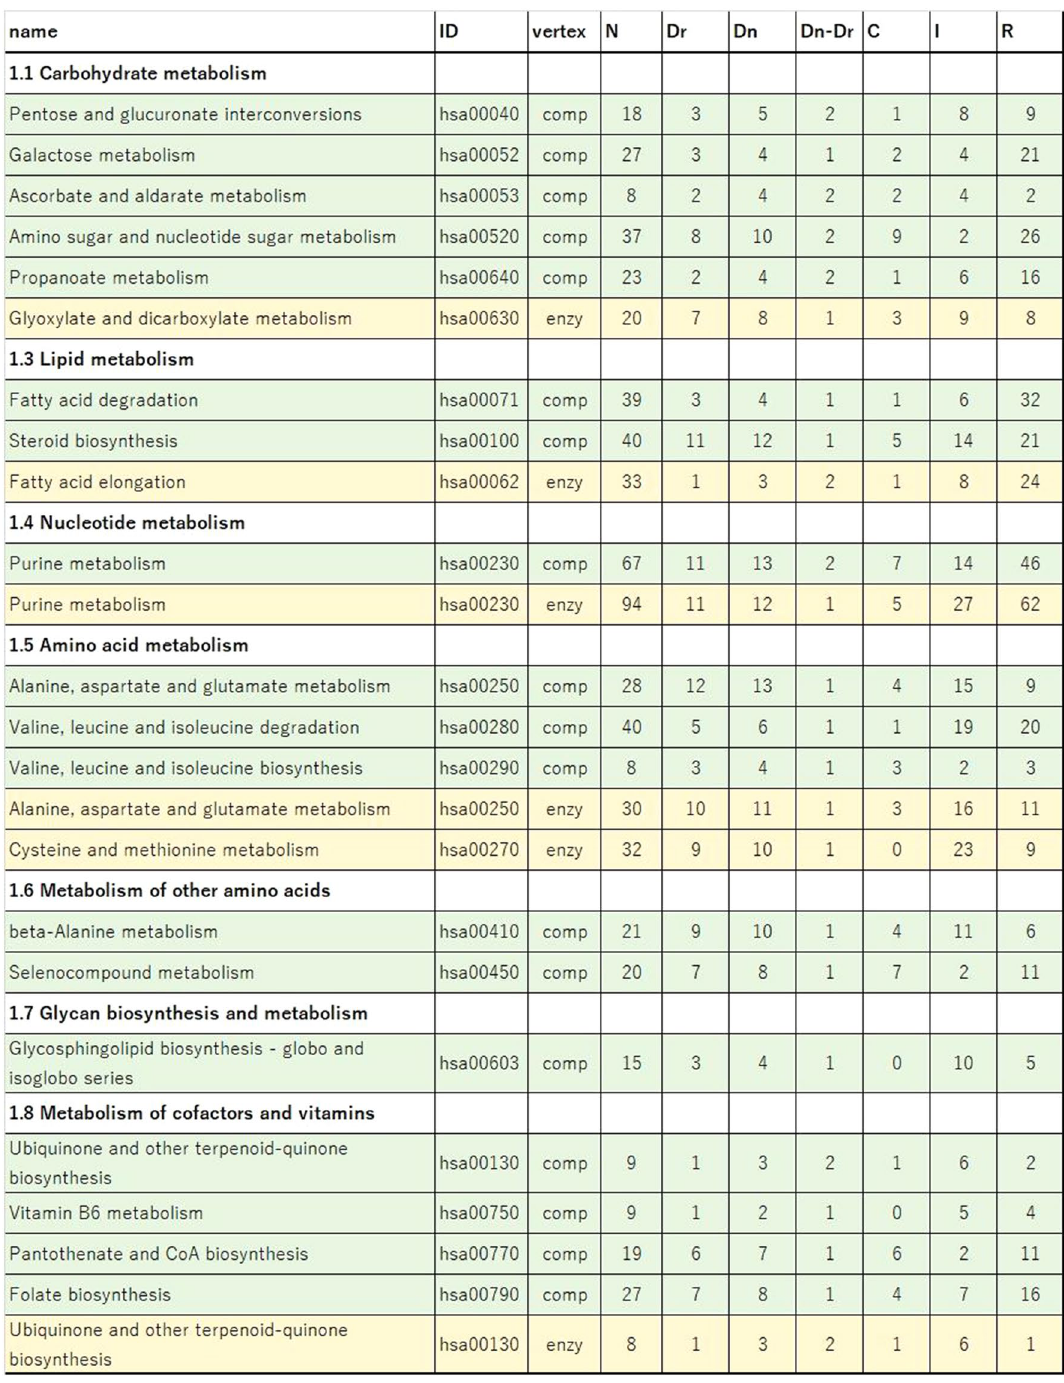
Table 1. The analysis of human pathways reveals a non-zero difference between the number of driver and driven nodes in 18 chemical compound networks (green) and 6 chemical reaction networks (yellow) (see Supplementary Table S1 online for complete results). From left to right, the columns indicate: pathway name, KEGG database pathway ID, and the type of network (compound network or chemical reaction (enzymes) network), numbers of nodes N, driver nodes (Dr), driven nodes (Dn) and the observed difference between driven and driver nodes (Dn–Dr). The numbers of identified critical (C), intermittent (I) and redundant (R) nodes are also